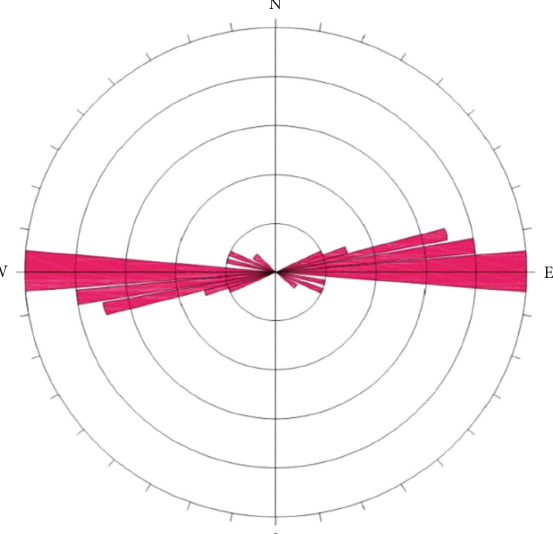
Figure 9: Distribution characteristics of the maximum horizontal principal stress direction in the northwest Jiaodong Peninsula.